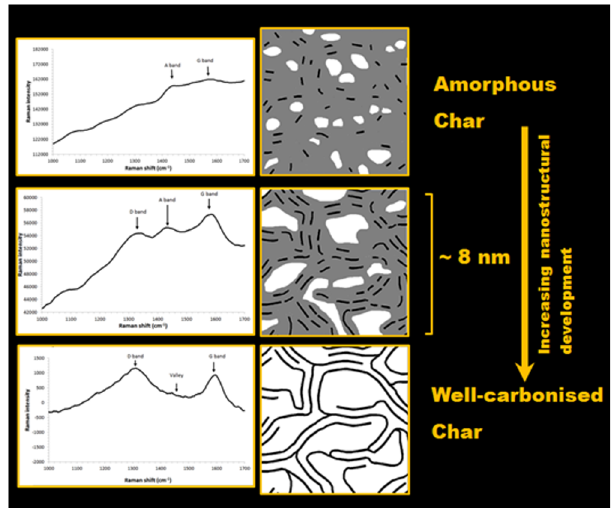
Figure 2. Sketches providing an overview of how features in Raman spectra of chars change as the extent of nanostructural development (or charring intensity) increases. In the illustrations of the char nanostructure, the black lines represent clusters of aromatic carbon which grow into a tangle of cross-linked graphene-like domains and the grey colour represents regions of hydrogen-rich amorphous